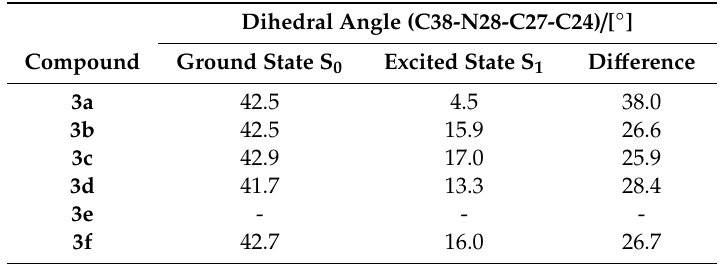
Table 7. Comparison of a compound’s geometry in the ground and excited states.